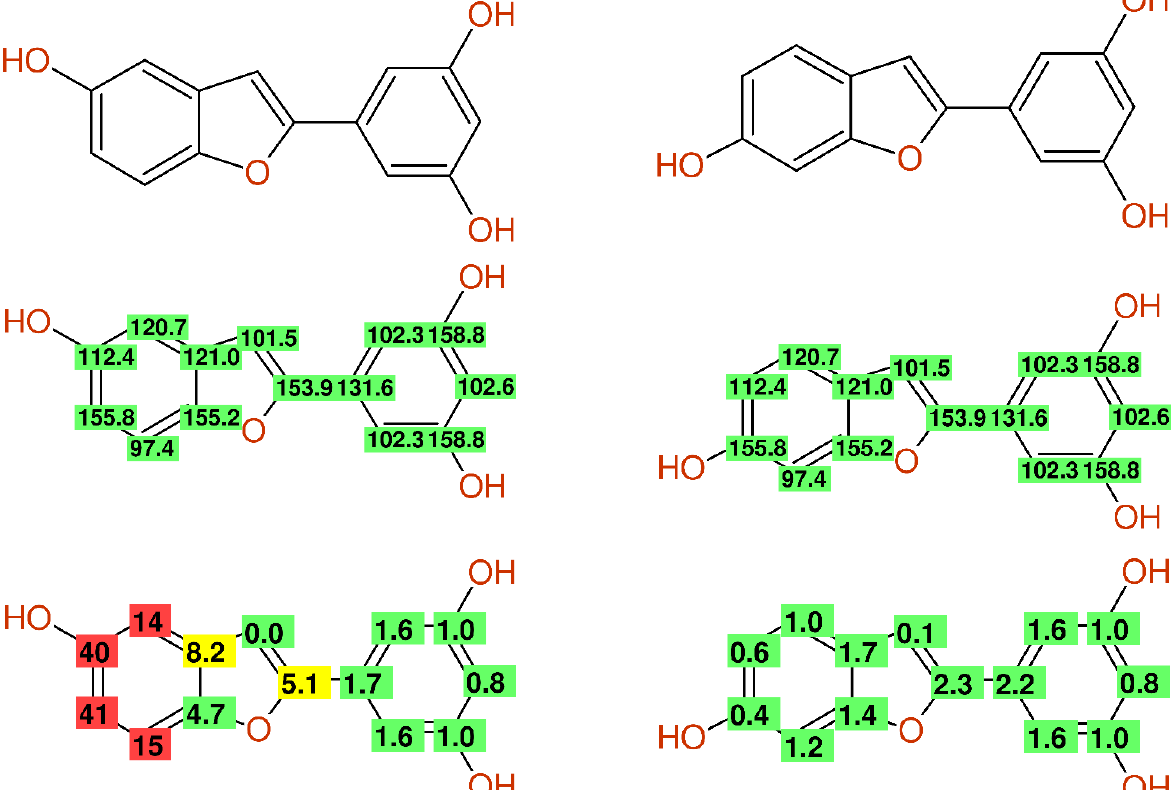
Figure 13. ( left ): Published structure of Moracin M (compound 7 in [41]) together with the given 13 C-NMR data and the deviations between the experiment and prediction. ( right ): Fully automatic structure revision leading to excellent coincidence between the experimental and predicted chemical shift values.